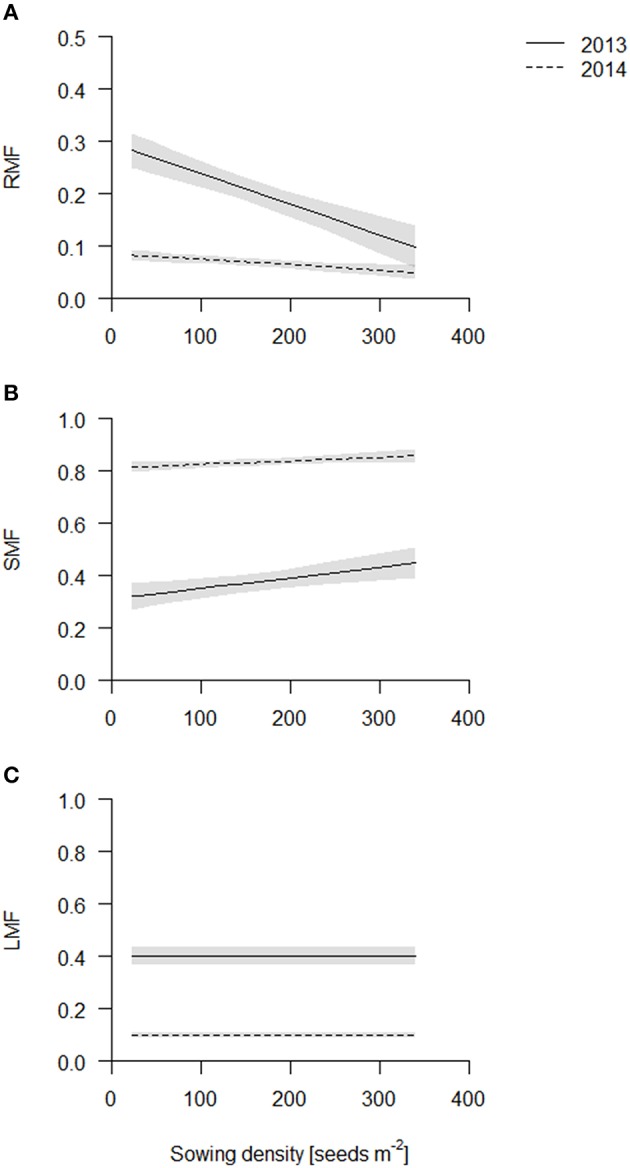
Biomass partitioning of the coring in 2013 (solid line) and 2014 (dashed line). Data are presented as best fits with 95% confidence interval (gray). For equations, R2 and p-values see Table S2. (A) Root mass fraction (RMF); (B) stem mass fraction (SMF); (C) leaf mass fraction (LMF).